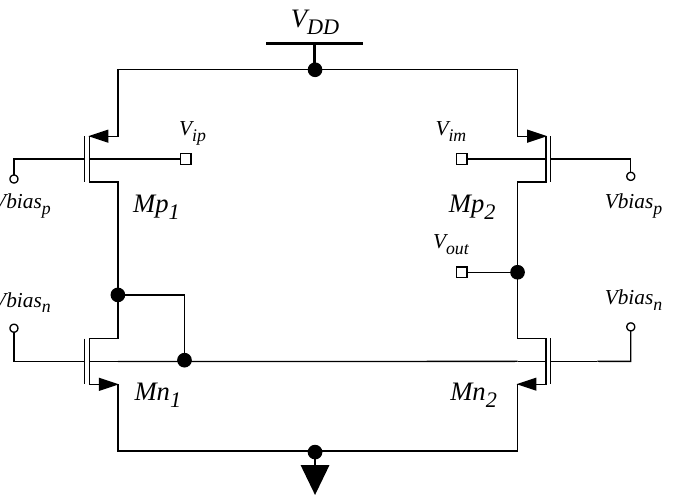
Figure 3. Conventional D2S converter: a standard body-driven current mirror is